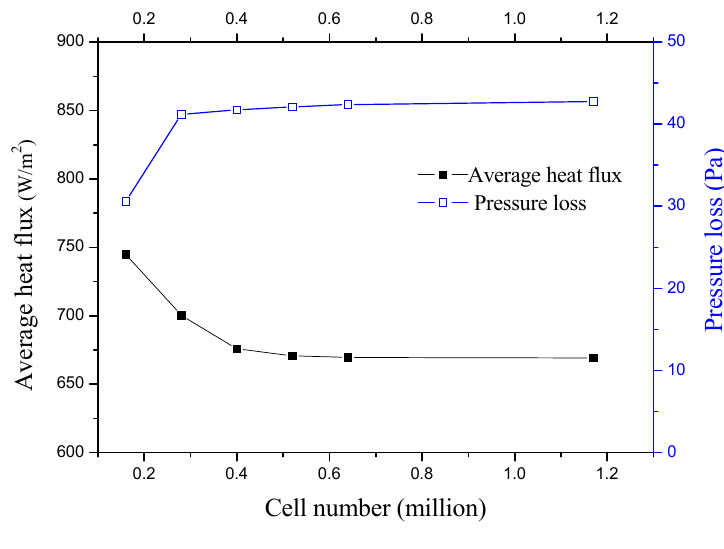
Figure 4. Grid Figure 4. Grid independence.